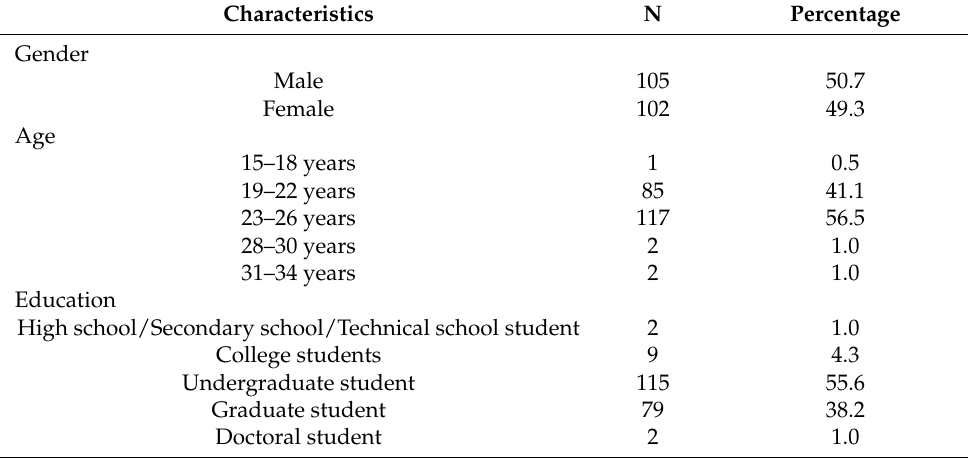
Table 2. The sample profile.